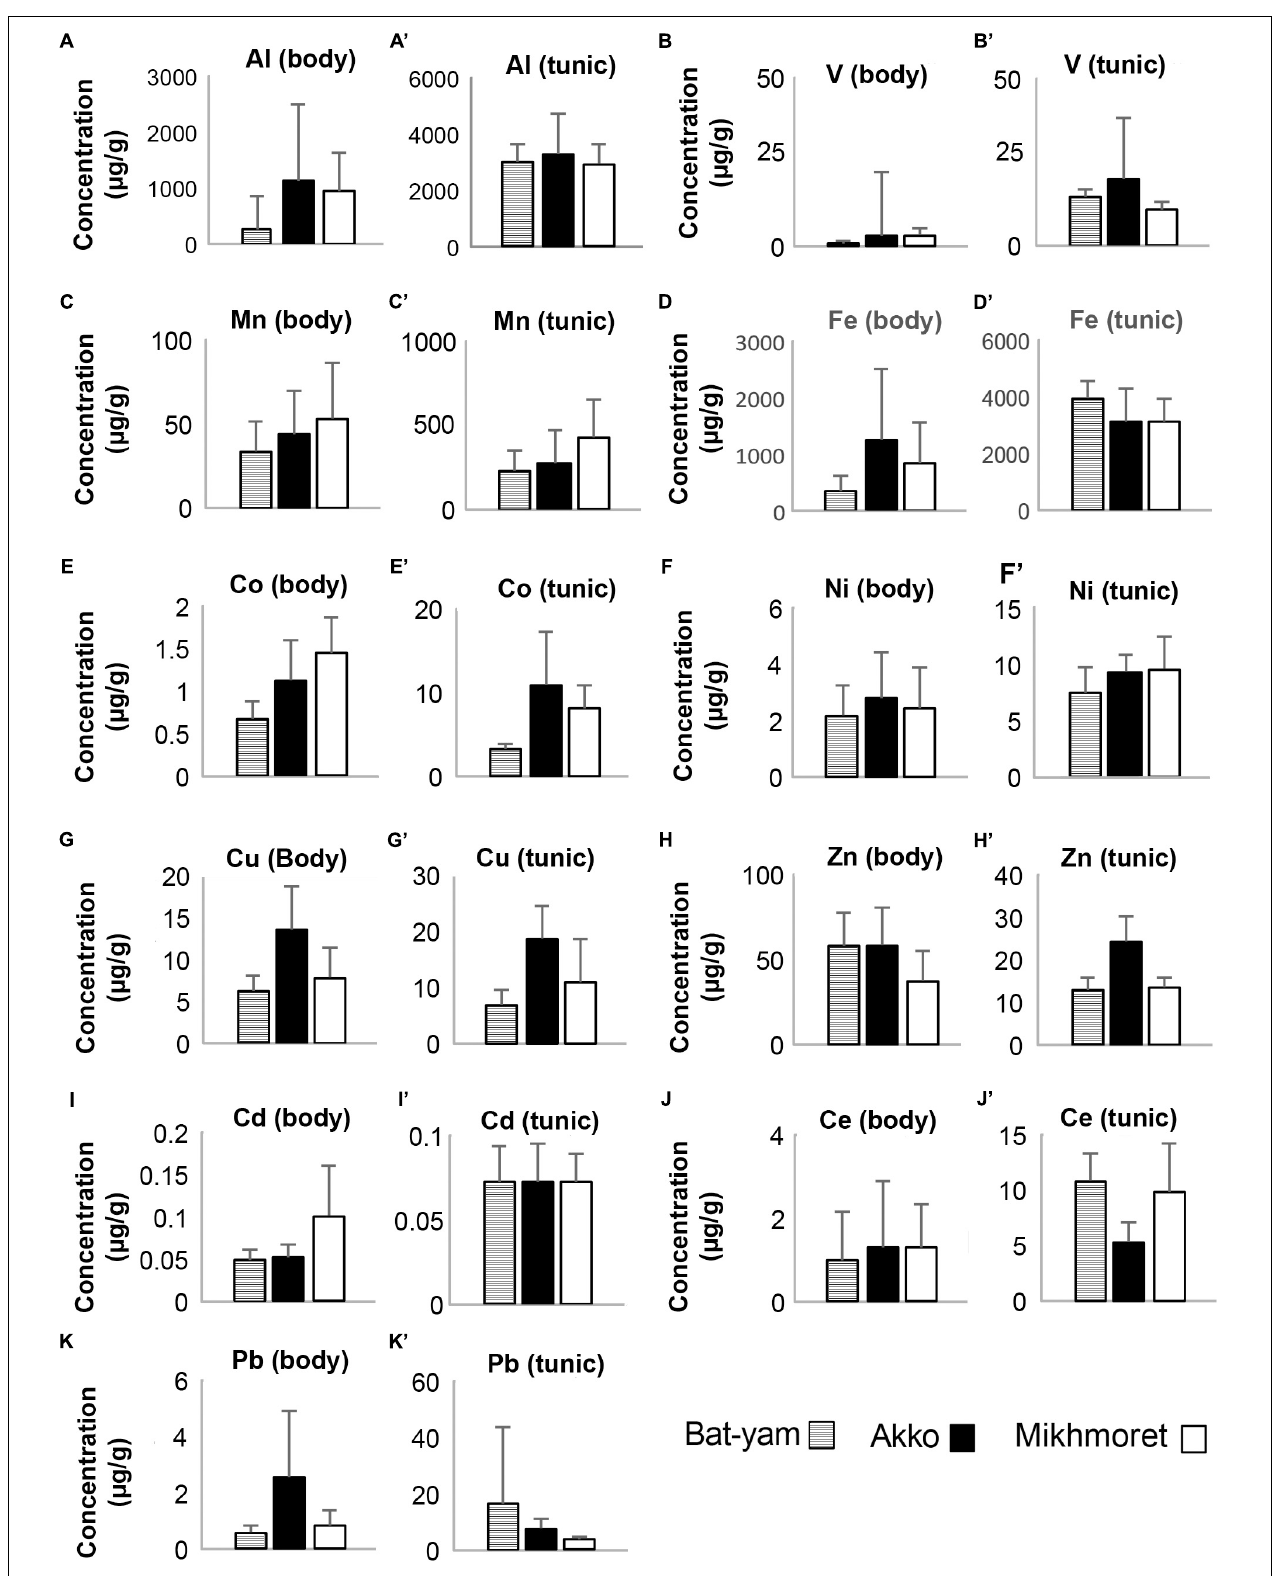
FIGURE 9 | Metal concentrations ( µ g/g) in the bodies (A–K) and tunics (A’–K’) of M. exasperatus , measured in samples from Bat-Yam, Akko, and Mikhmoret, in spring 2017 (Mean ± SD) ( n = 3 – 7).